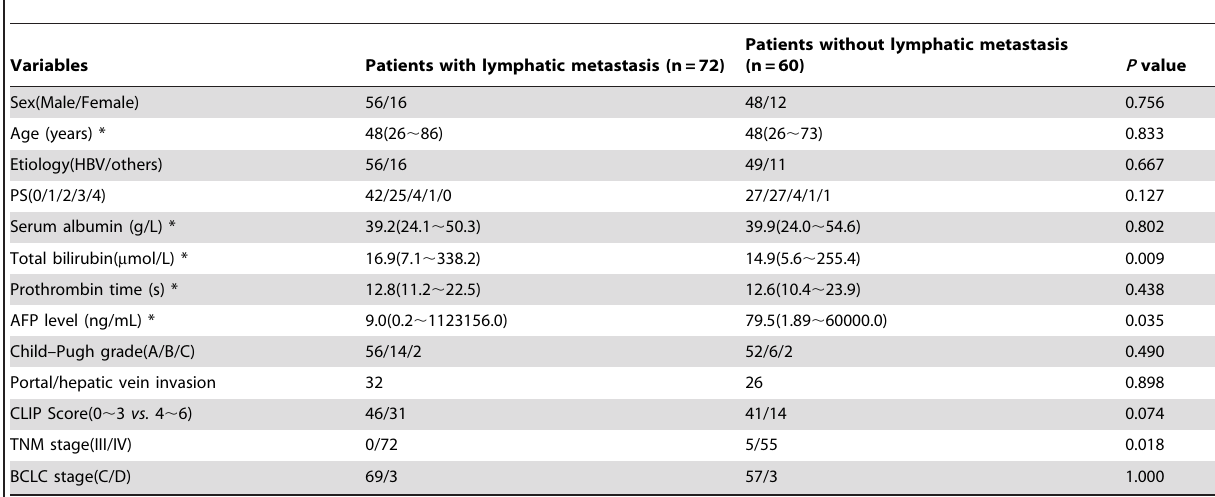
Table 4. Clinical profile of HCC patients with or without lymphatic metastasis.